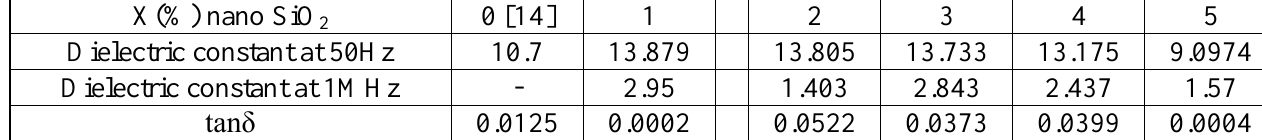
Fig.10: Tanδ for composites (unsaturated polyester resin with filler. Table 2: Dielectric constant and tanδ values at 50 and 1MHz.